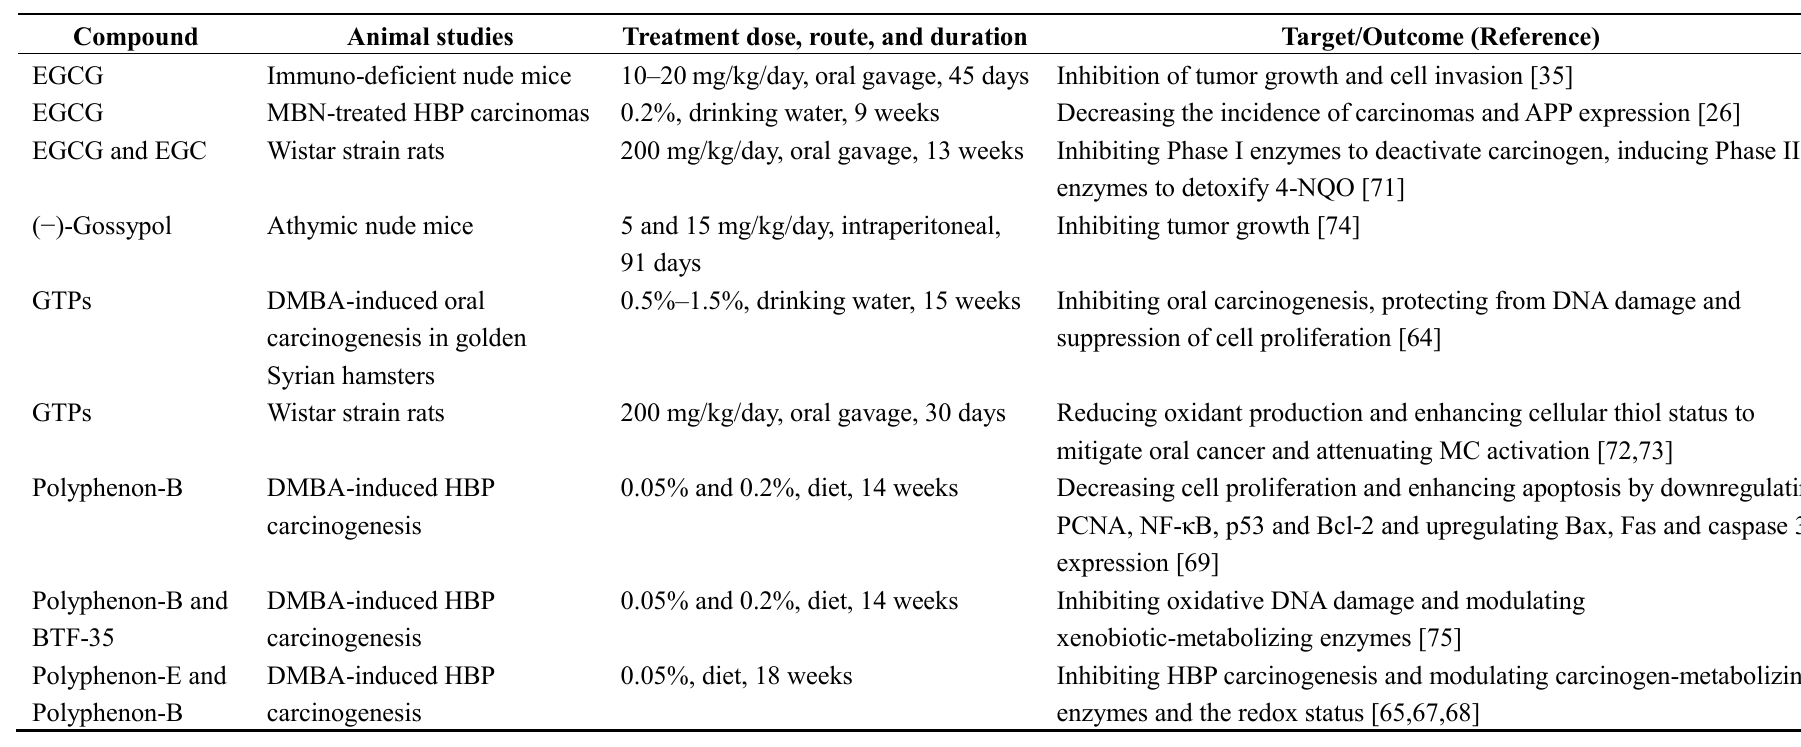
Table 2. Summary of in vivo studies of dietary polyphenols against oral